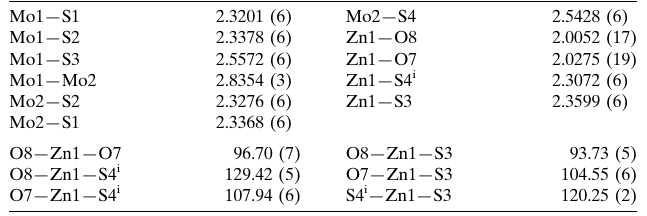
Selected geometric parameters (A˚ , (cid:2) ).